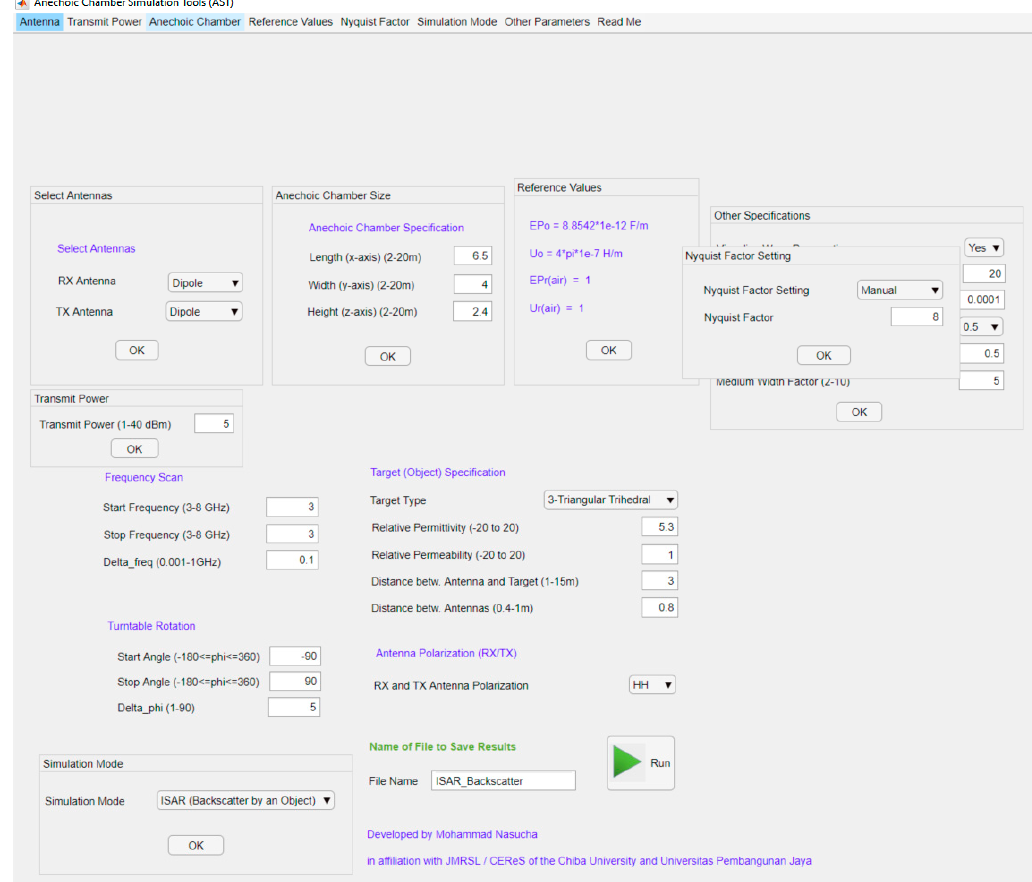
Figure 5. The appearance of the AST_V1 user interface.